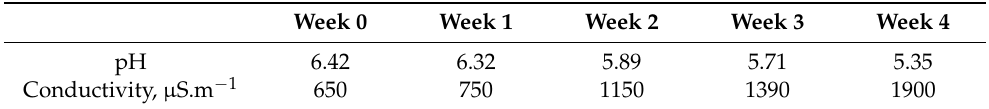
Table 2. Changes in AW parameters over time.